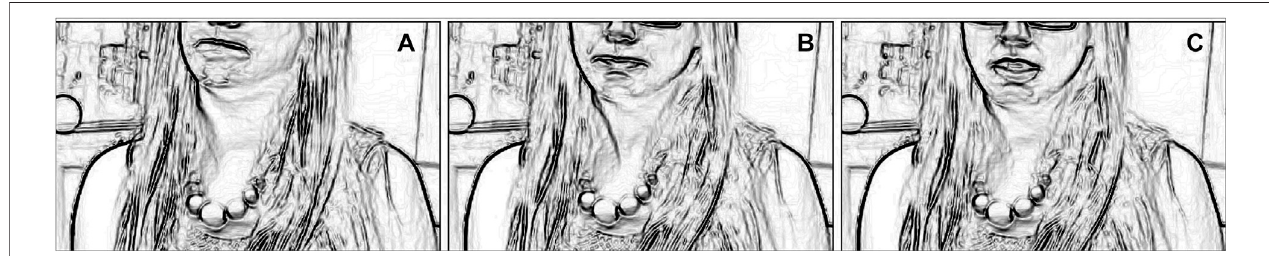
FIGURE2| Imagesofswallowingfrom Example5 .Thespeaker(pictured)says “ Belindagot-uhm: ① (0.7SWALLOW ② )CLICK ③ a([ei])(0.6)grant ” . (A) :takenat theendof “ uhm ” .Notethetightlypressedlipswiththeoutersurfacespressedinwards. (B) :takenduringtheswallow.Notethevisibletendonsintheneckasthelarynxis raised. (C) : the swallow is released into a click, and the lips are